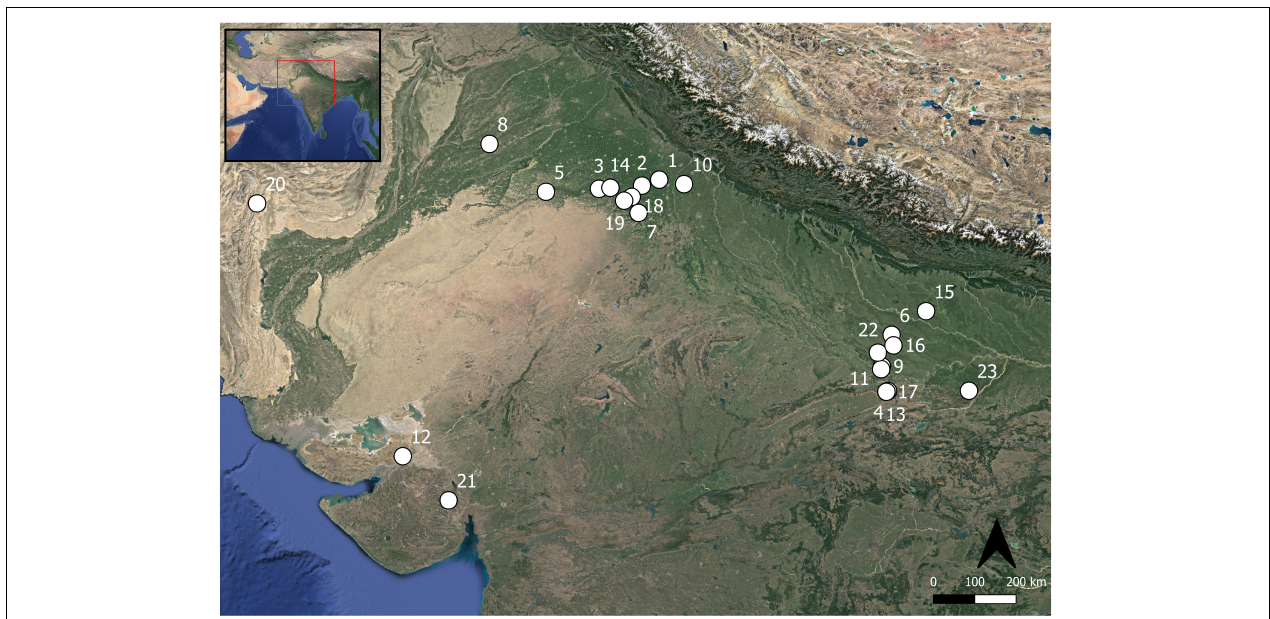
FIGURE 1 | Map of sites discussed in this study. (1) Bahola, (2) Balu, (3) Banawali, (4) Chopani Mando, (5) Dabli vas Chugta, (6) Damdama, (7) Farmana, (8) Harappa, (9) Hetapatti, (10) Hulas, (11) Jhusi, (12) Kanmer, (13) Koldihwa, (14) Kunal, (15) Lahuradewa, (16) Mahadaha, (17) Mahagara, (18) Masudpur I, (19) Masudpur VII, (20) Pirak, (21) Rangpur, (22) Sarai Nahar Rai, and (23) Senuwar